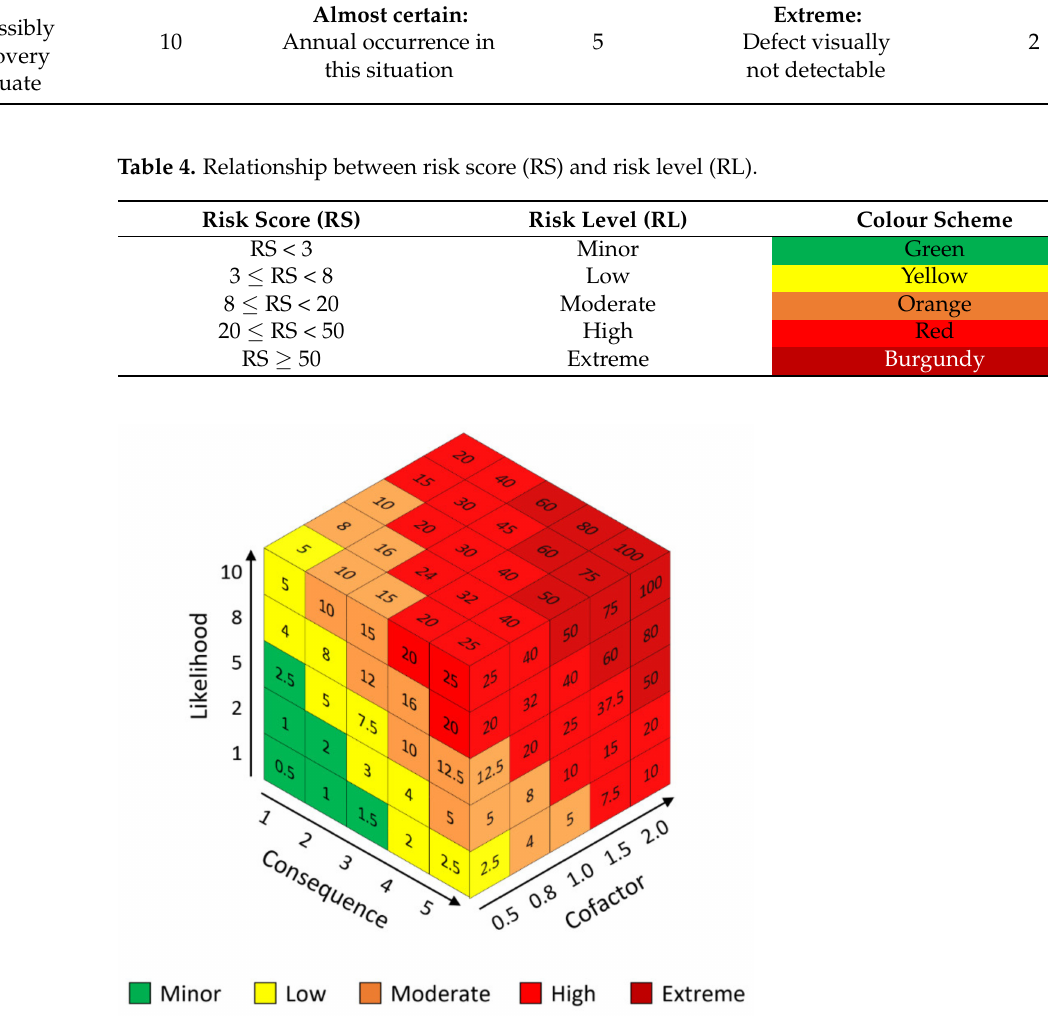
Figure 5. Three-dimensional risk matrix including